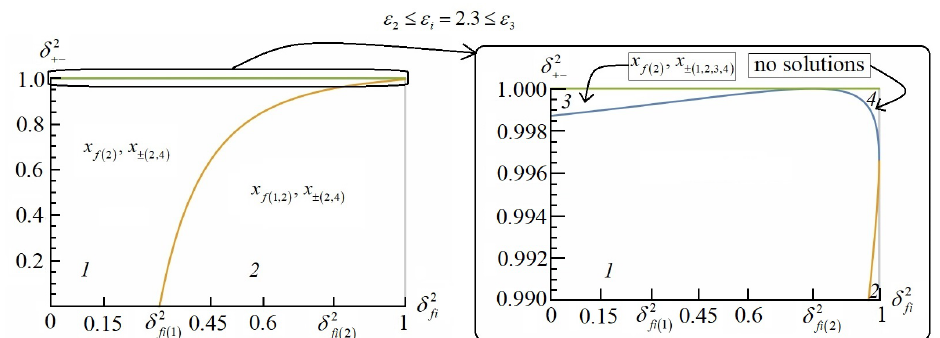
Figure 7. Regions in ( δ 2 , δ 2 + − ) –space with different possible values of particle energies. The energy fi of the initial electron is ε 2 ≤ ε i = 2.3 ≤ ε 3 (see Conditions (40), (42), (44)). The right picture shows the area of the left picture for δ 2 + − ∈ [ 0.99,1 ] . The blue line shows the dependence of the first (cid:16) (cid:17) δ 2 characteristic opening angle of the pair δ 2 , ε i = 2.3 on the outgoing angle of the scattered + − ( 1 ) fi electron at the energy of the initial electron ε i = 2.3. The orange line shows the dependence of the (cid:16) (cid:17) δ 2 second characteristic opening angle of the pair δ 2 , ε i = 2.3 on the outgoing angle of the + − ( 2 ) fi scattered electron at the energy of the initial electron ε i =